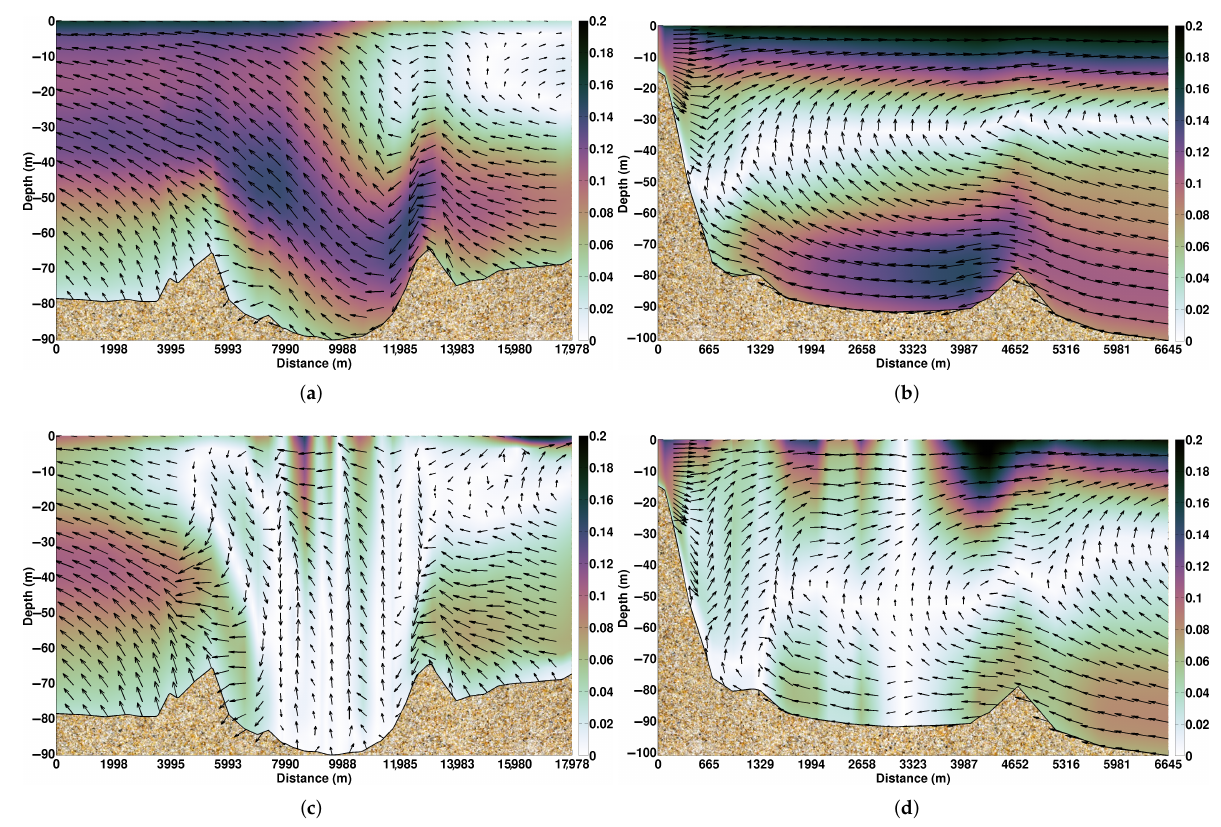
Figure 11. Vertical cross sections for the Rio de Janeiro turbines site; colored surface shows mean velocity (m · s − 1 ) while vectors show direction. Simulation without the presence of turbines (upper panel) and with the turbines (lower panel). ( a , c ) Refers to RJ1 transect; ( b , d ) refers to RJ2 transect. See Figure 1d. for a better location of the